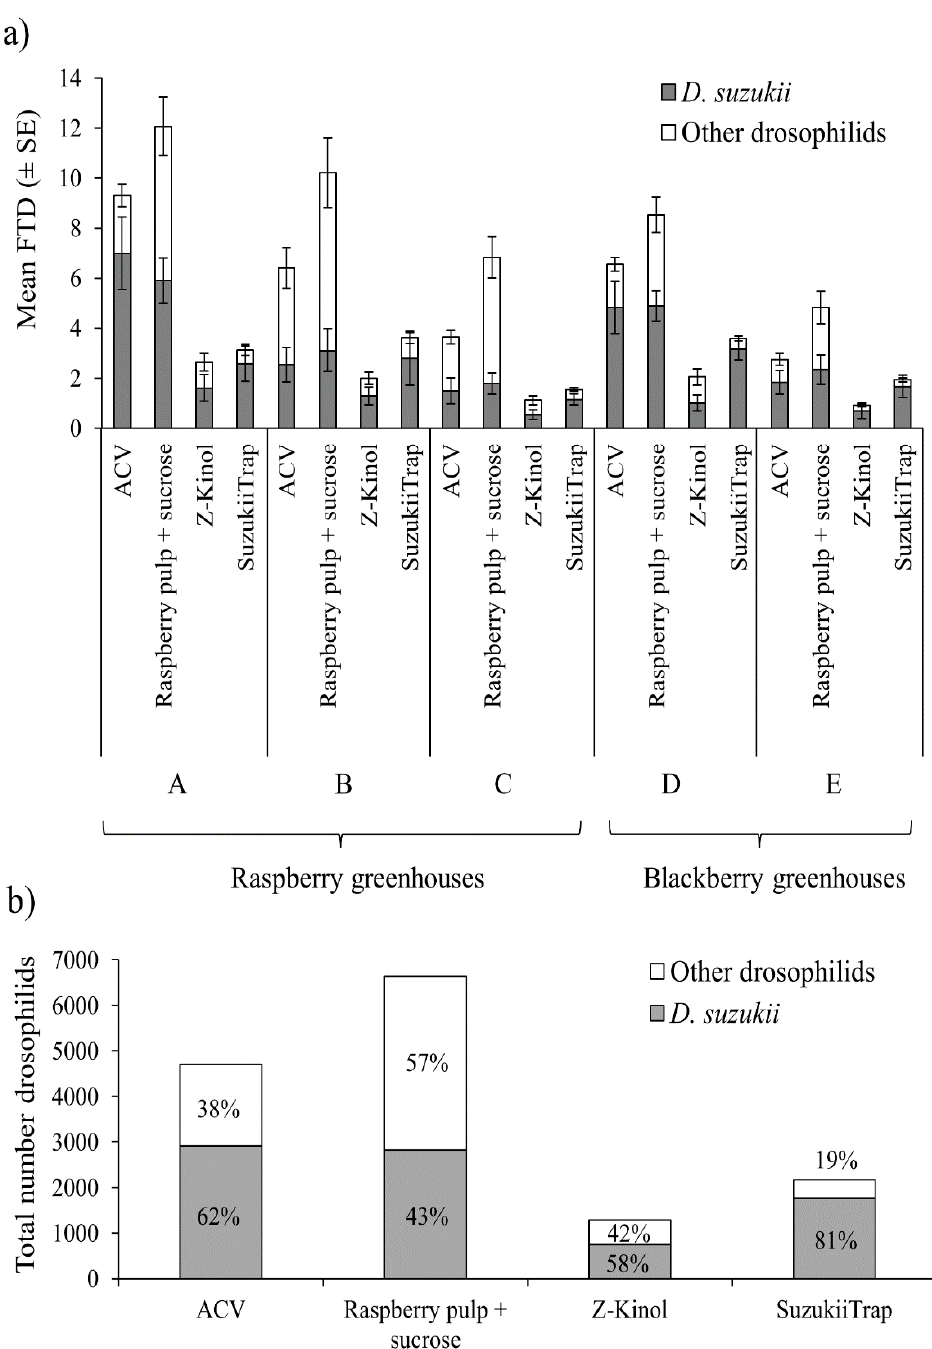
Figure 5. ( a ) Mean numbers of flies / trap / day (FTD ± SE) for D. suzukii (grey columns) and other drosophilid species (white columns) trapped using di ff erent attractants in three commercial polytunnels of raspberry (A–C) and two of blackberry (D,E). ( b ) Total numbers of D. suzukii flies (grey columns) and other drosophilid species (white columns), that were trapped for each attractant across all polytunnel trials shown in ( a ). Values within columns indicate percentage species composition. The mean total number of drosophilid flies (all species including D. suzukii ) trapped per trap per day also di ff ered significantly among attractants ( χ 2 = 165.30; df = 3; p < 0.001) and crop (raspberry vs. blackberry) ( χ 2 = 6.49; df = 1; p = 0.011), but the interaction of attractant*crop was not